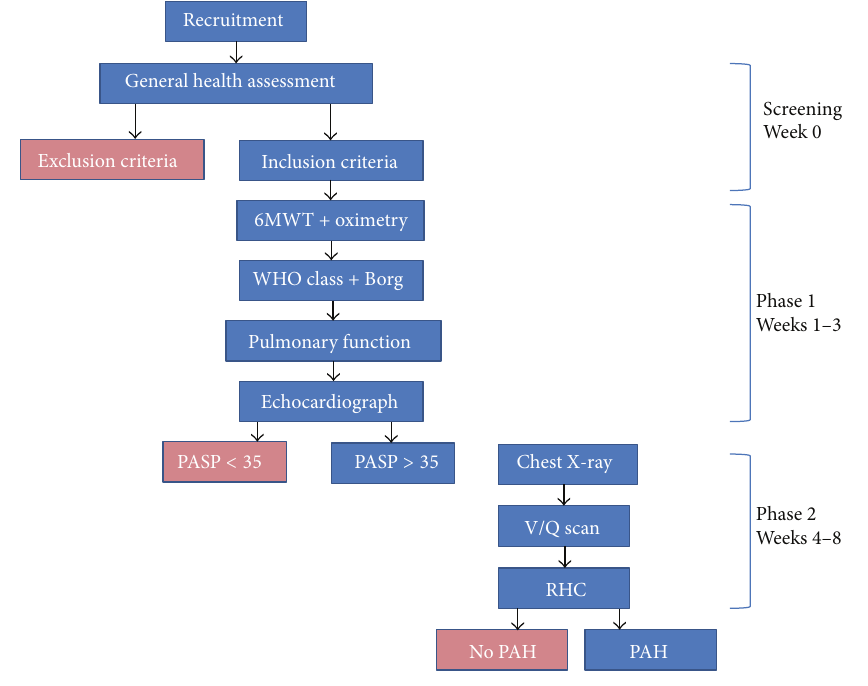
Figure 1: SAPHIRE study